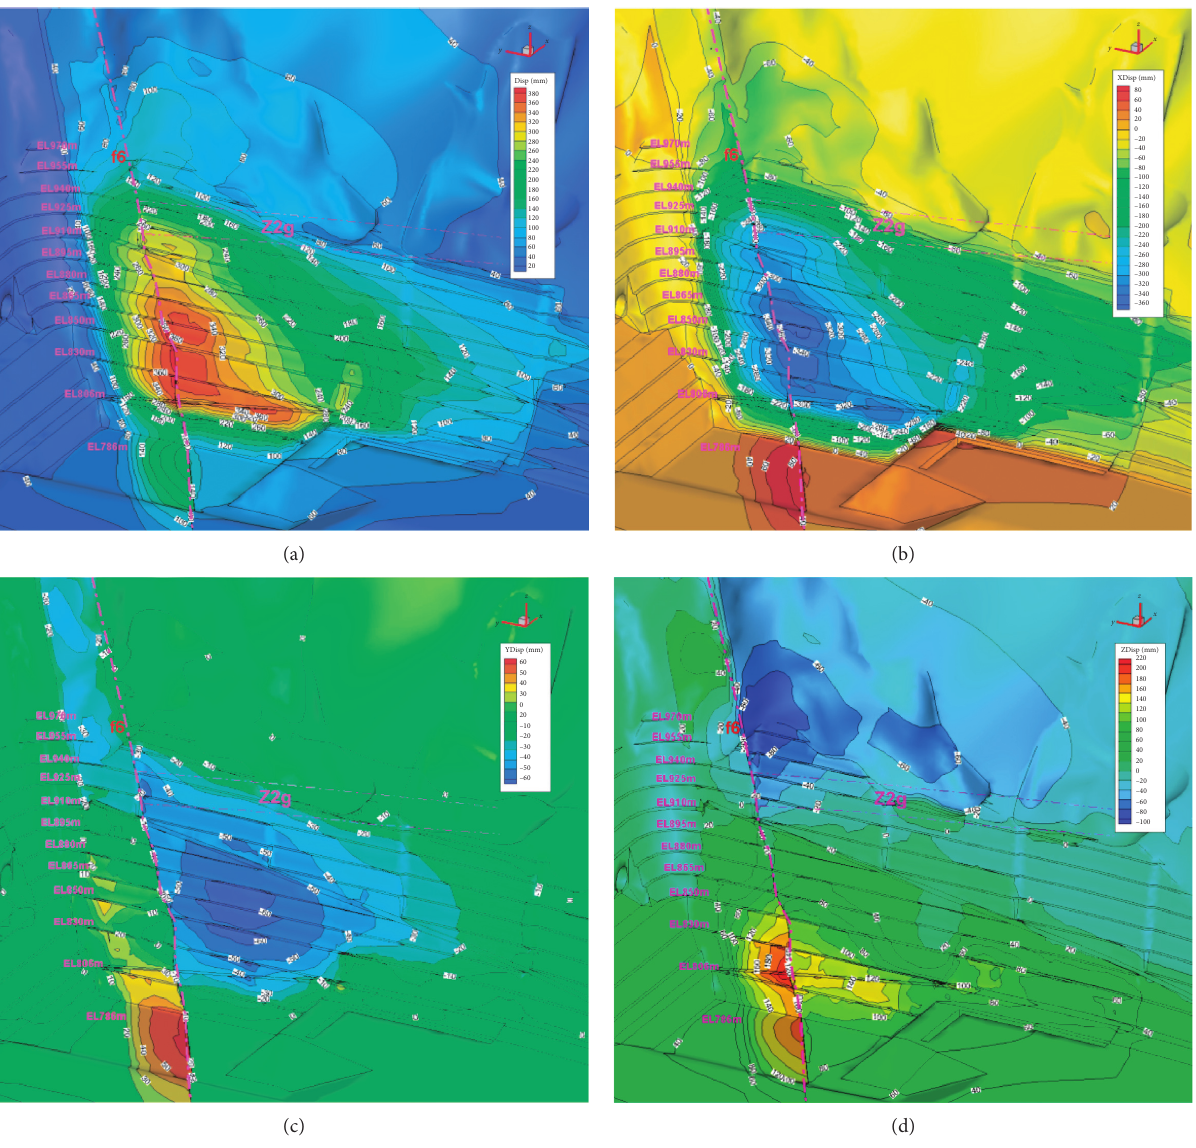
Figure 6: Variation characteristics of displacement field after excavation. (a) Integral displacement field of slope. (b) Displacement field of slope in X -direction. (c) Displacement field of slope in Y -direction. (d) Displacement field of slope in Z